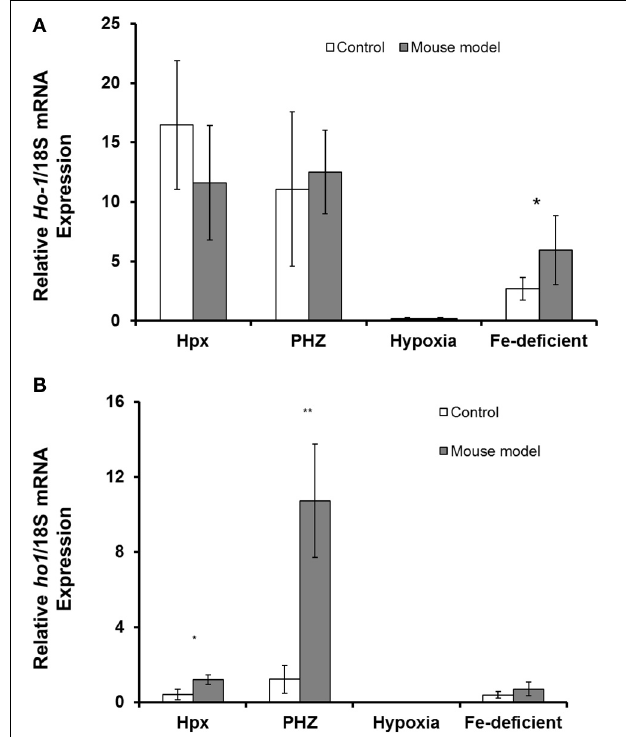
FIGURE 3 | Quantitative Real-Time PCR of Ho1 mRNA levels in spleen and liver of mouse models with enhanced erythropoiesis. (A) Ho1 mRNA levels in the spleen of Hpx, PHZ-treated, hypoxic, and iron deficient mice. Analysis by Students’ T -test showed significant effects of Ho1 only in iron-deficient spleen tissues, ( P < 0 . 01) over the control samples. (B) Ho1 mRNA expression in the liver of Hpx, PHZ-treated, hypoxic, and iron deficient mice. Analysis by Students’ T -test showed significant effects of Ho-1 mRNA in Hpx ( P < 0 . 05), and PHZ liver tissues, ( P < 0 . 01) over the control samples. Data are mean ± s.e.m. of four observations in each group and are expressed as a ratio of 18S mRNA in arbitrary